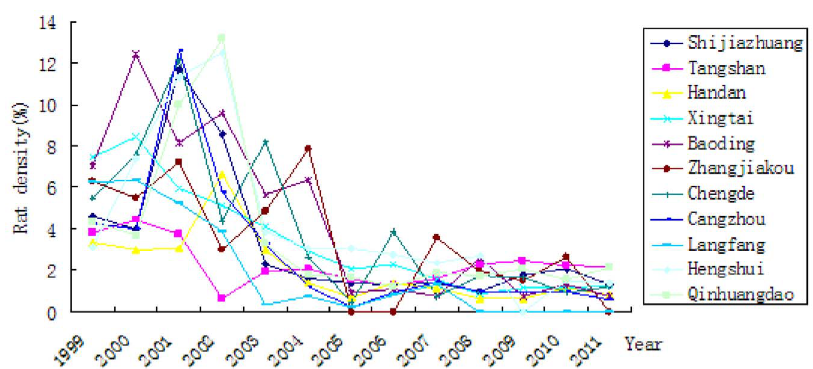
Figure 3. Rat density in cities of Hebei province from 1999 to 2011.